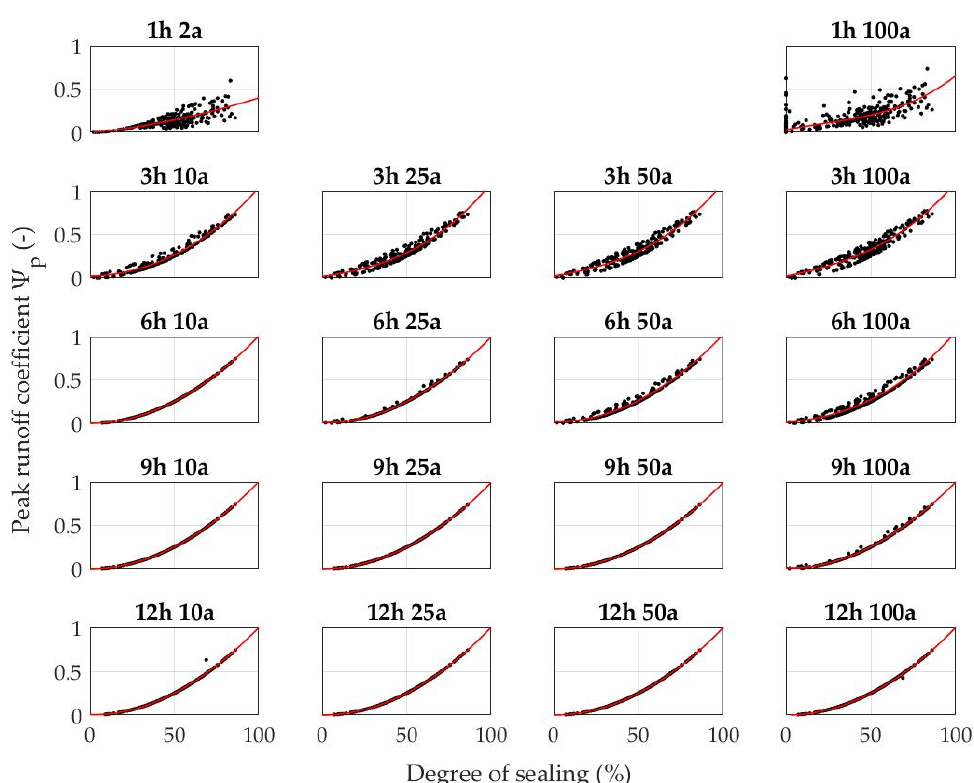
Figure 6. Correlation diagrams based on peak runoff coefficients and the degree of sealing (subheadings are composed of rainfall duration and return period).